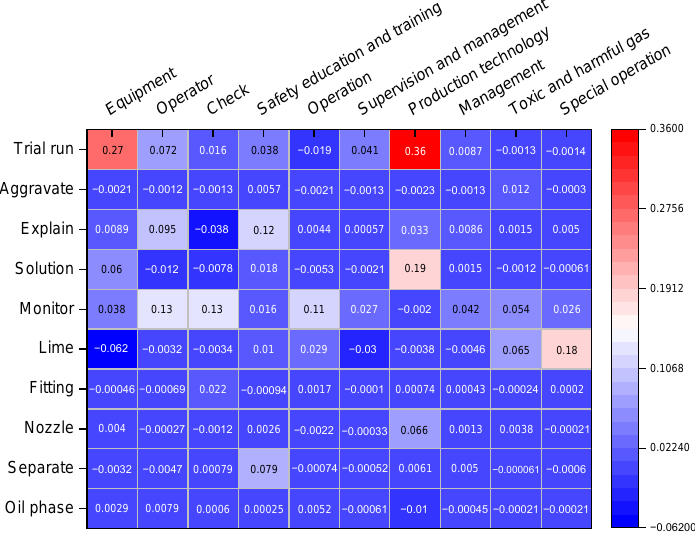
Figure 8. The heat map of correlation coefficients.